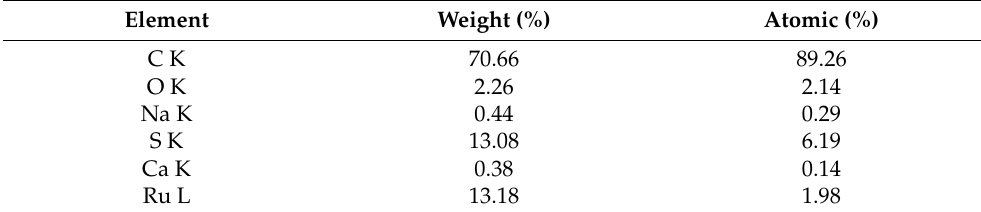
Table 1. Elemental analysis of N749-BD film.